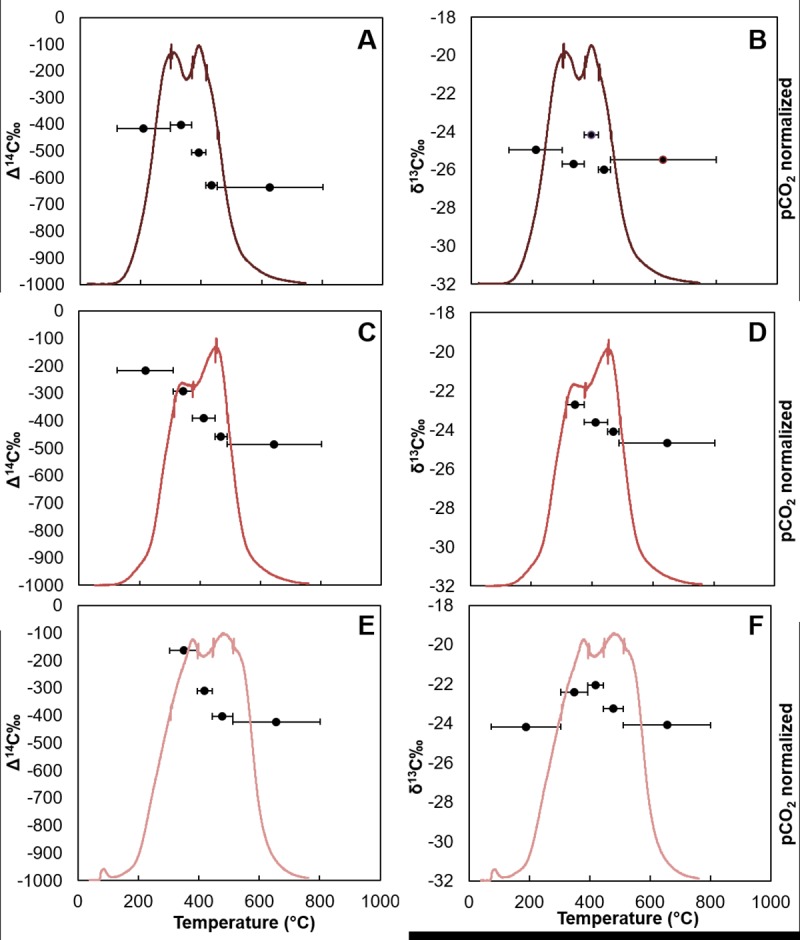
CO2 thermograph and isotopic composition of evolved
CO2 for site GIP 17.Temperature interval of CO2 fractions indicated by horizontal
bars. A) GIP17 2010 Δ14C, B) GIP17 2010 δ13C, C)
GIP17 2011 Δ14C, D) GIP17 2011 δ13C, E) GIP17 2015
Δ14C, F) GIP17 2015 δ13C.